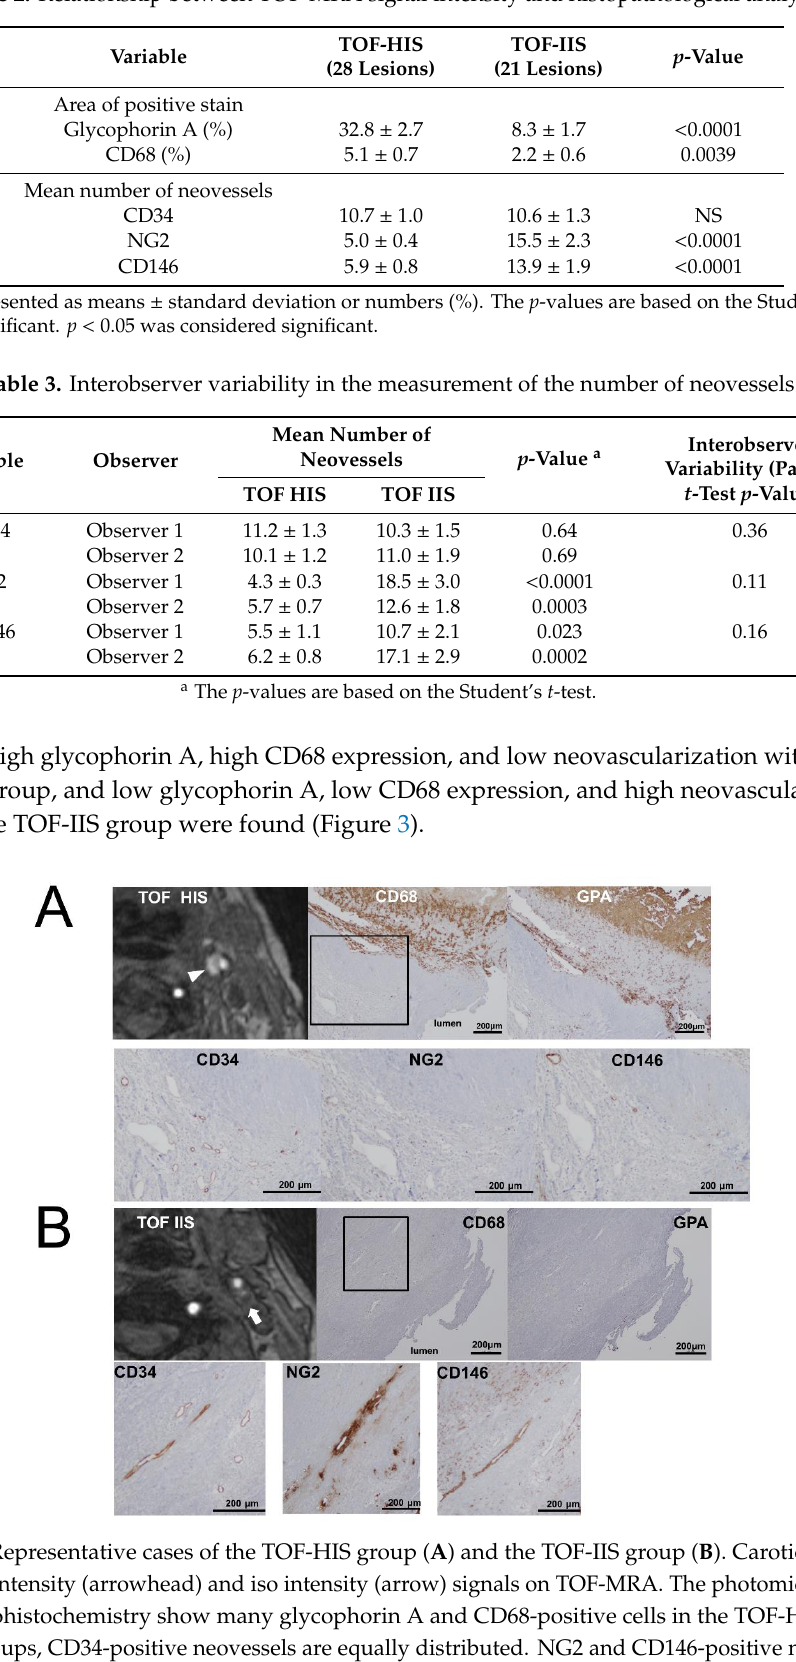
Table 2. Relationship between TOF-MRA signal intensity and histopathological analysis.